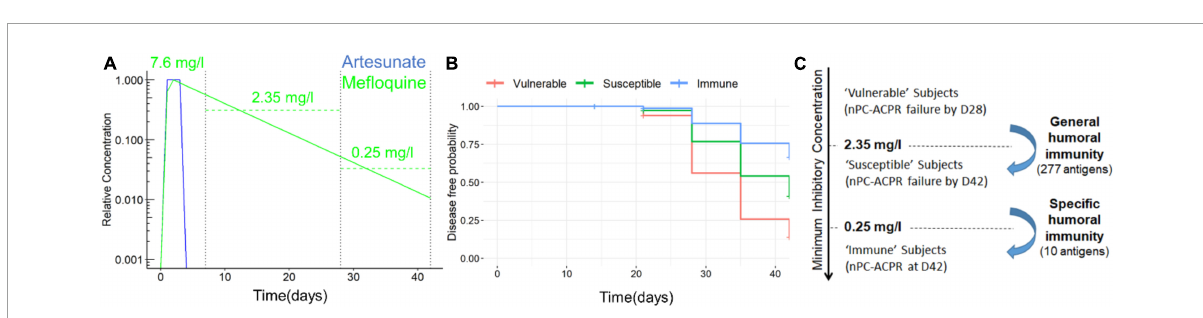
FIGURE6 PK profile of ASMQ and estimation of MIC of mefloquine. (A) Simulated PK profile of ASMQ for artesunate (blue) and mefloquine (green). Estimated peak concentration, and average concentration between day 7 and 28, and day 28 and 42 are shown for mefloquine are labeled. (B) Estimated disease-free probability for all ASMQ subjects classified as “susceptible,” “intermediate,” and “immune” based on humoral immunity using the day 28 and 42 predictive models. (C) Relationship between humoral immunity and MIC of mefloquine based on ACPR outcome, univariate analysis, and simulated PK